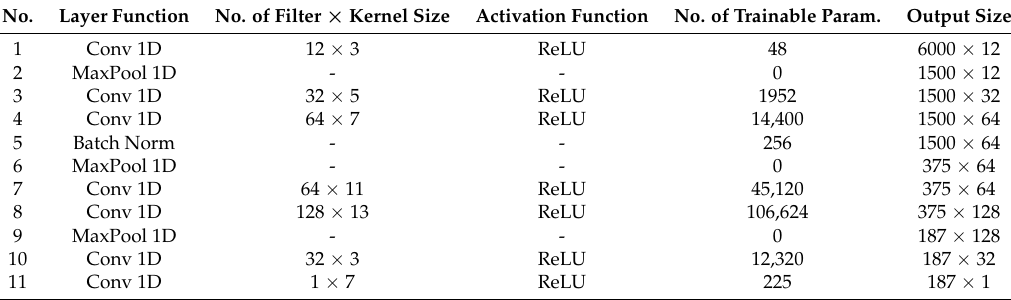
Figure 1. Proposed system model for the deep convolutional autoencoder. Table 1. Detail parameters for each layer in the proposed encoder.